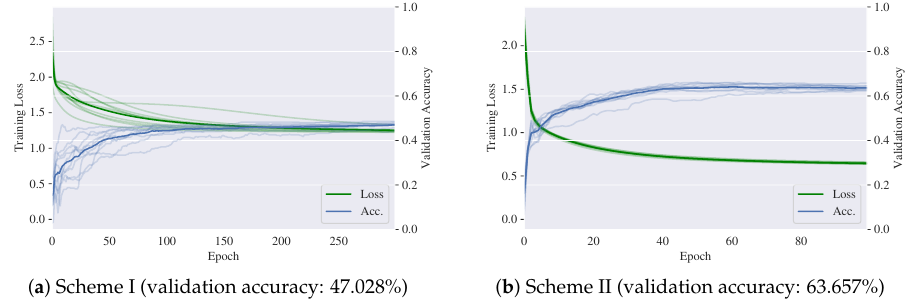
Figure 13. Training loss and validation accuracy of DiscNet on the Orchard dataset (using 30% of data for